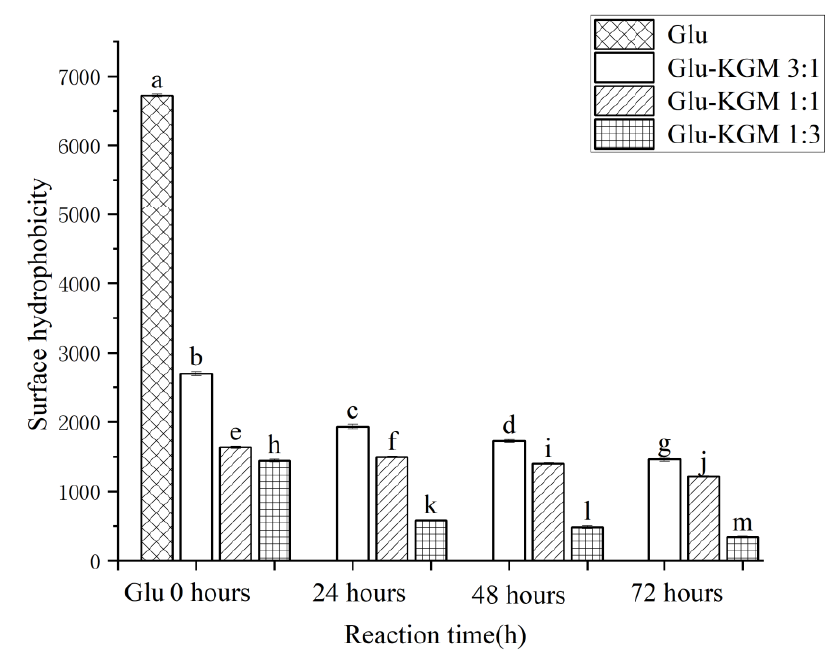
Figure 8. Surface hydrophobicity of gluten, mixtures, and conjugates, respectively. The results with different letters were significantly different ( p < 0.05).